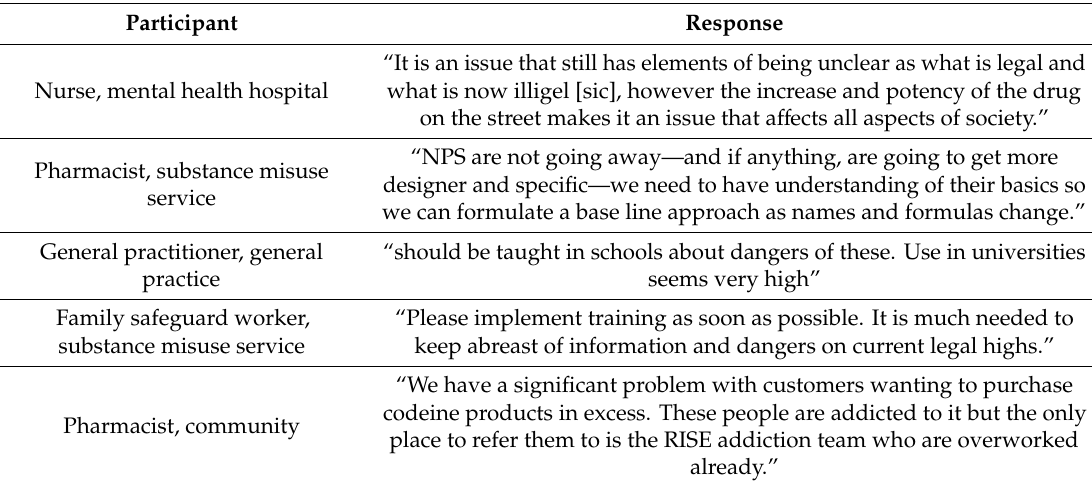
Table 3. Free text responses regarding other comments and